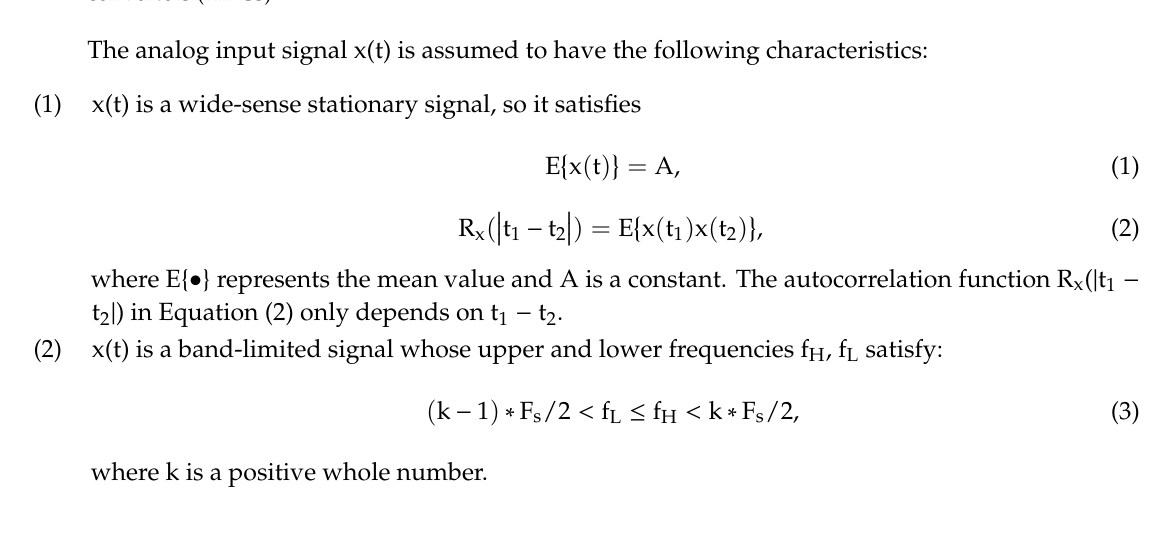
Figure 1. Architecture proposed to compensate the timing mismatch in M-channel analog to digital converters (ADCs).